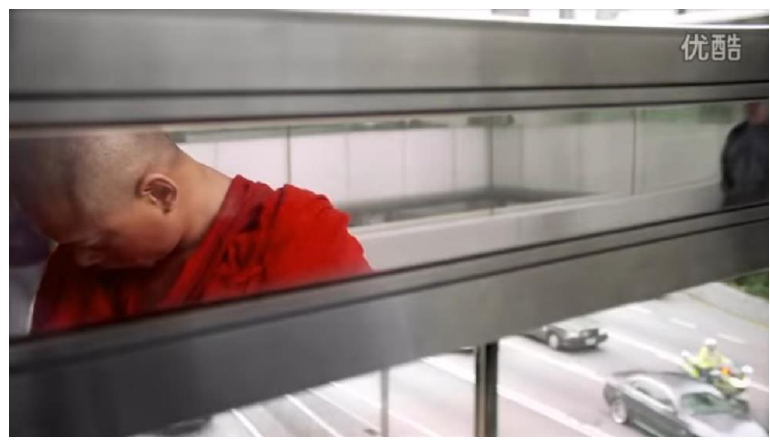
Figure 9. A window of reflection.